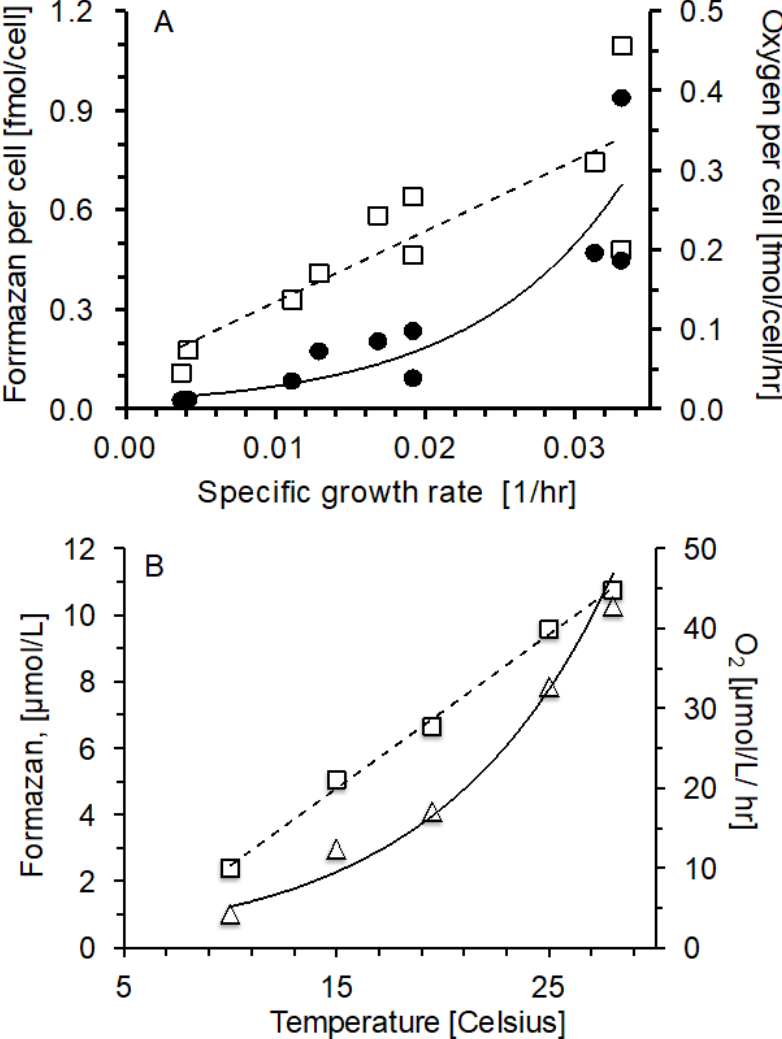
Int. J. Mol. Sci. 2019 , 20 , x FOR PEER REVIEW Figure 3. Oxygen consumption and formazan vs. specific growth rate and temperature. ( A ) Assemblages of marine prokaryotes in continuous cultures, formazan production per cell ( , dashed line, y = 21.4 x + 0.11, r 2 = 0.69, p ≤ 0.05), oxygen consumption per cell ( continuous line, y = 0.01 e 98.7 x , r 2 = 0.87, p ≤ 0.05). ( B ) V. harveyi in batch cultures, oxygen consumption ( , continuous line, y = 1.51 e 0.12 x , r 2 = 0.97, p ≤ 0.05) and formazan production ( , dashed line, y = 0.46 x − 2.16, r 2 = 0.99, p ≤ 0.05). Error bars are not shown because they are too small.